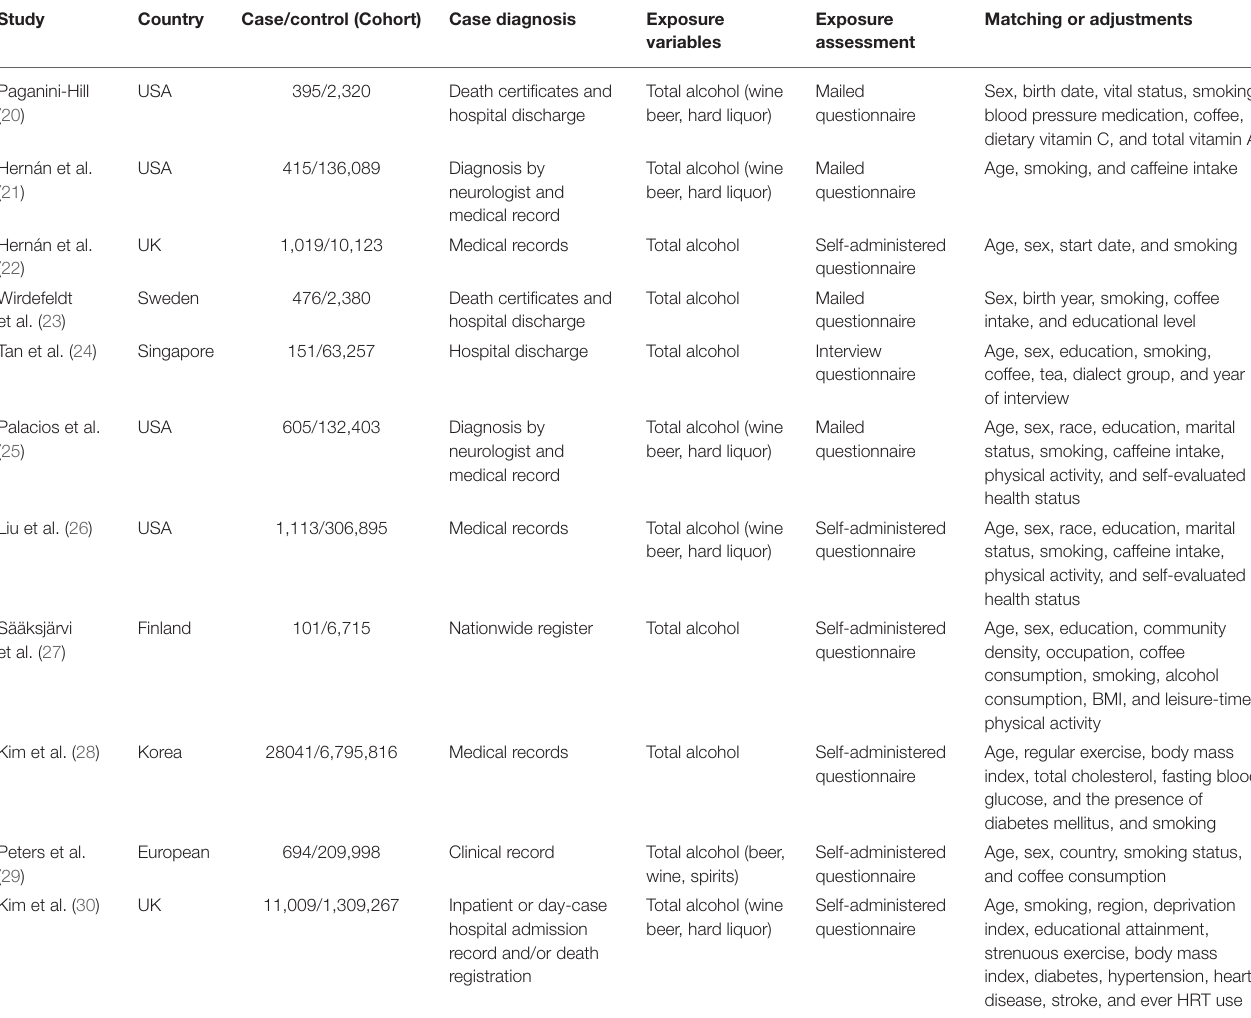
TABLE 1 | Characteristics of the included